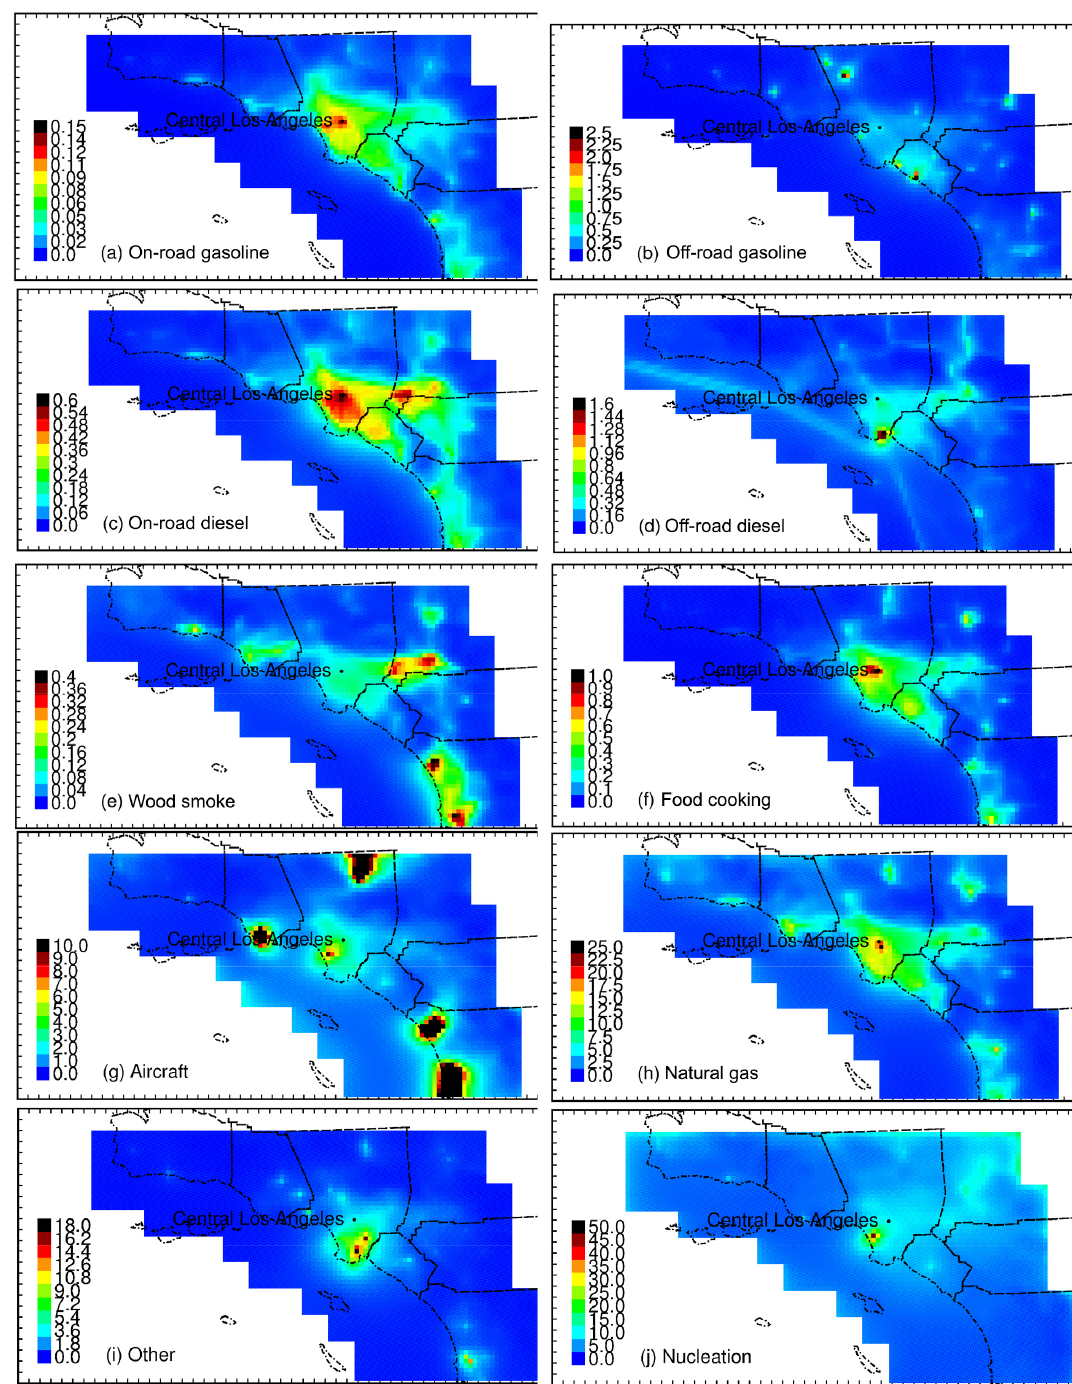
Figure 18. Spatial distribution of particle number from major sources in southern California (unit: kcountscm − 3